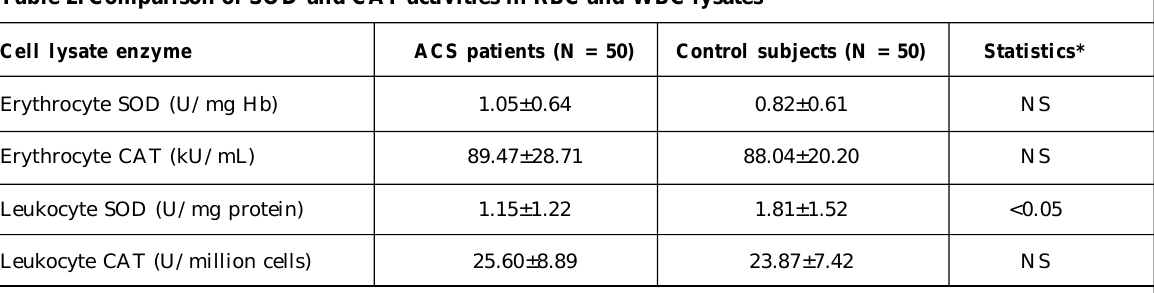
Table 2: Comparison of SOD and CAT activities in RBC and WBC lysates Cell lysate enzyme